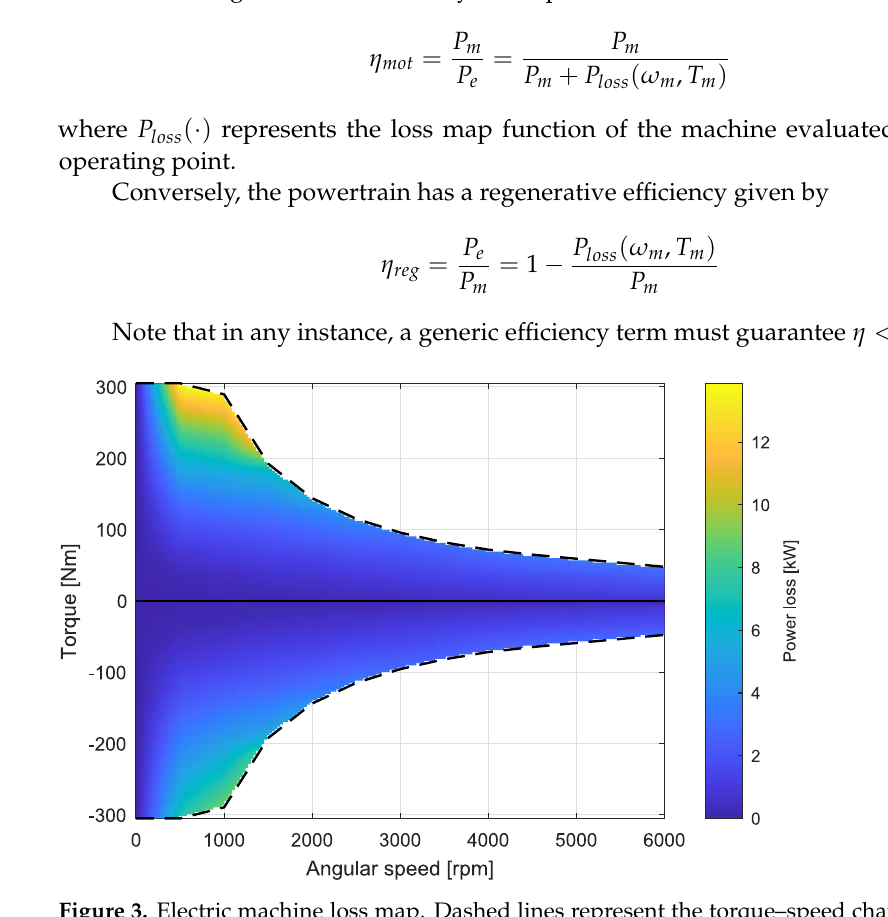
Figure 3. Electric machine loss map. Dashed lines represent the torque–speed characteristic limit. The solid line separates the motoring quadrant (positive torque) from the regenerative quadrant (negative